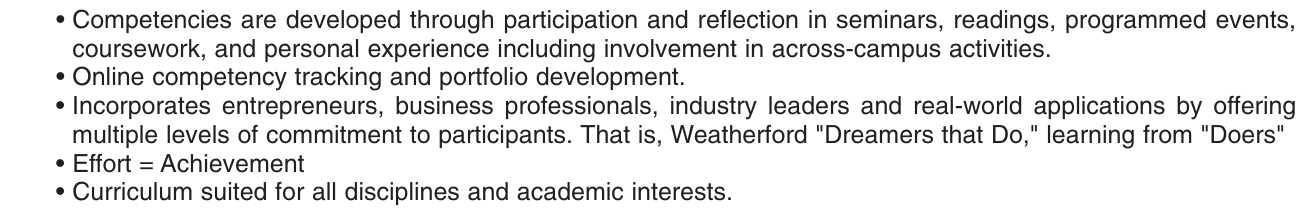
Figure 4. TICK Program: Promotional